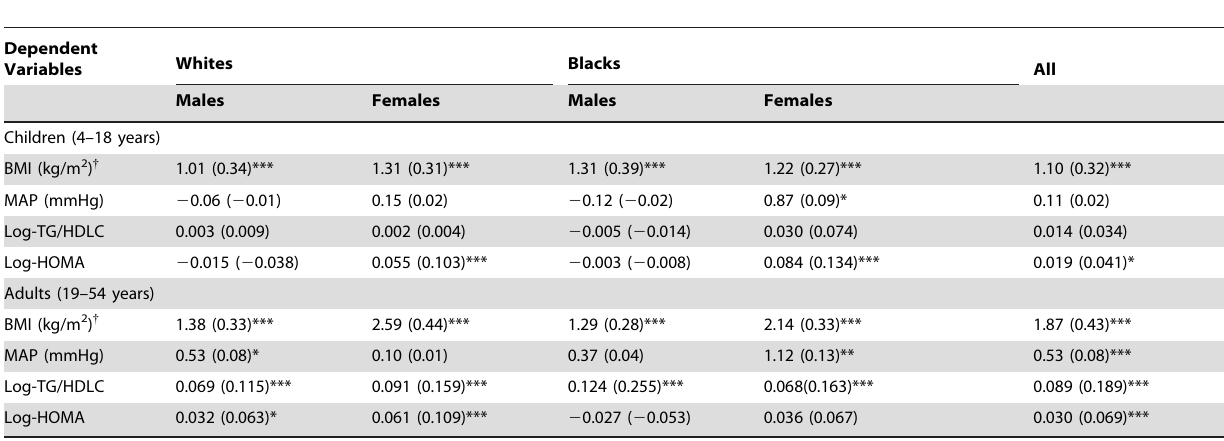
Table 2. Unstandardized (standardized) regression coefficient of MetS components on uric acid in children and adults by race and gender, adjusted for age and BMI.